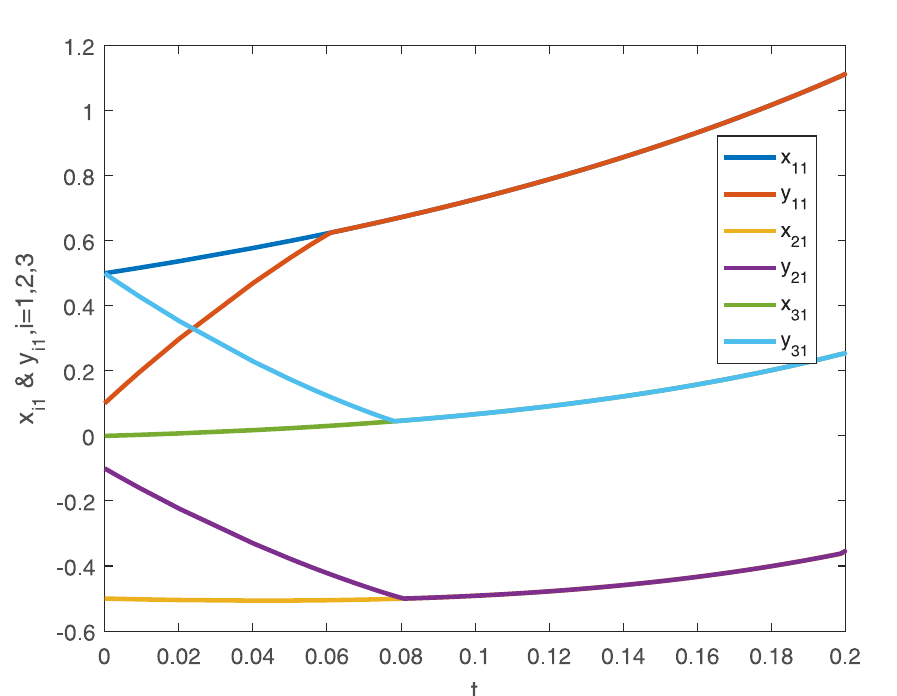
Fig 5. The the first dimensional trajectories of drive-response systems (18) and (19) with initial conditions x 1 ( t 0 ) = [0.5 + sin ( t ), cos ( t )− 0.5] T , x 2 ( t 0 ) = [ sin ( t )− 0.5, 0.5 + cos ( t )] T , x 3 ( t 0 ) = [ sin ( t ), cos ( t )] T and response system (19) with initial conditions y 1 ( t 0 ) = [0.1 + sin ( t ), cos ( t )− 0.1] T , y 2 ( t 0 ) = [ sin ( t )− 0.1, 0.1 + cos ( t )] T , y 3 ( t 0 ) = [0.5 + sin ( t ), cos ( t ) − 0.5] T under the controller (8).